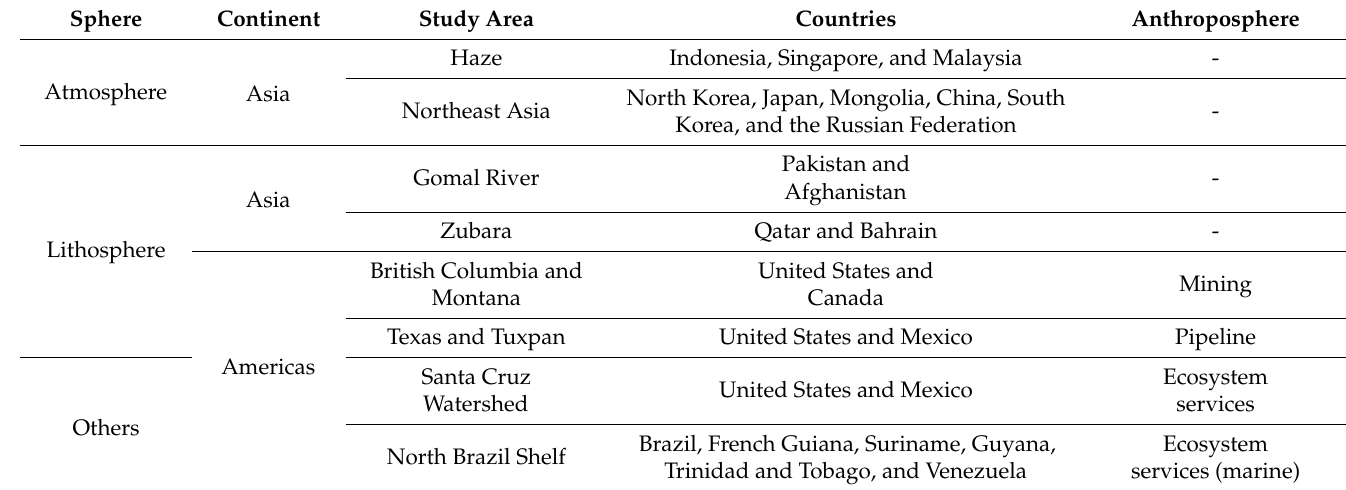
Table 8. The natural resource conflict cases related to the atmosphere, lithosphere, and others.